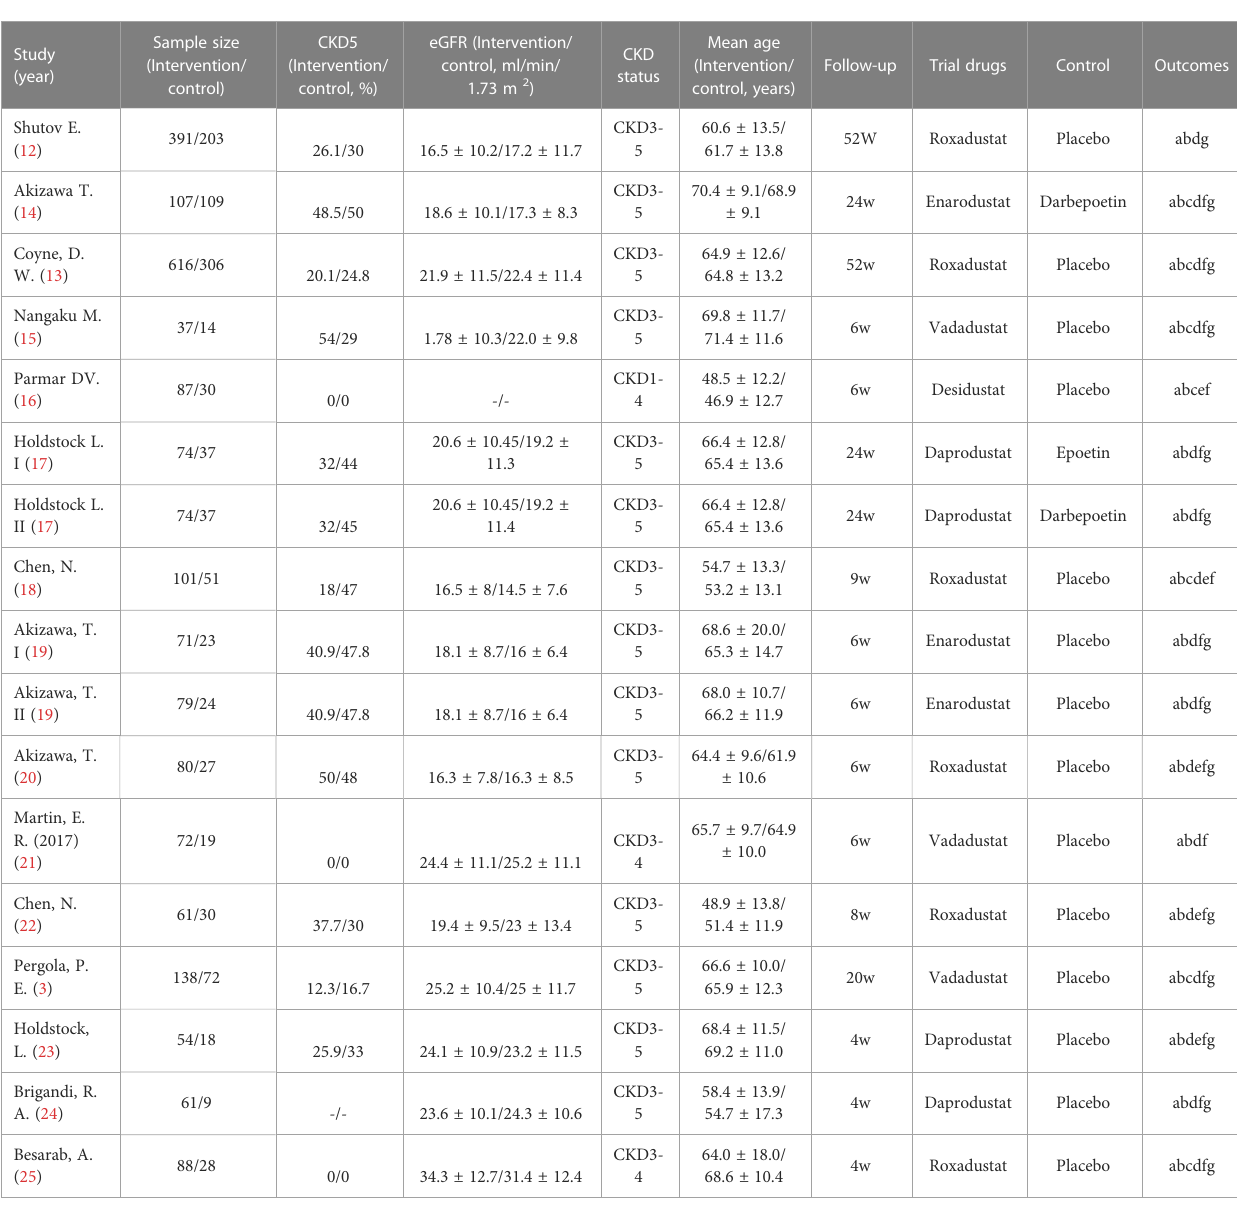
TABLE 1 Characteristics of included